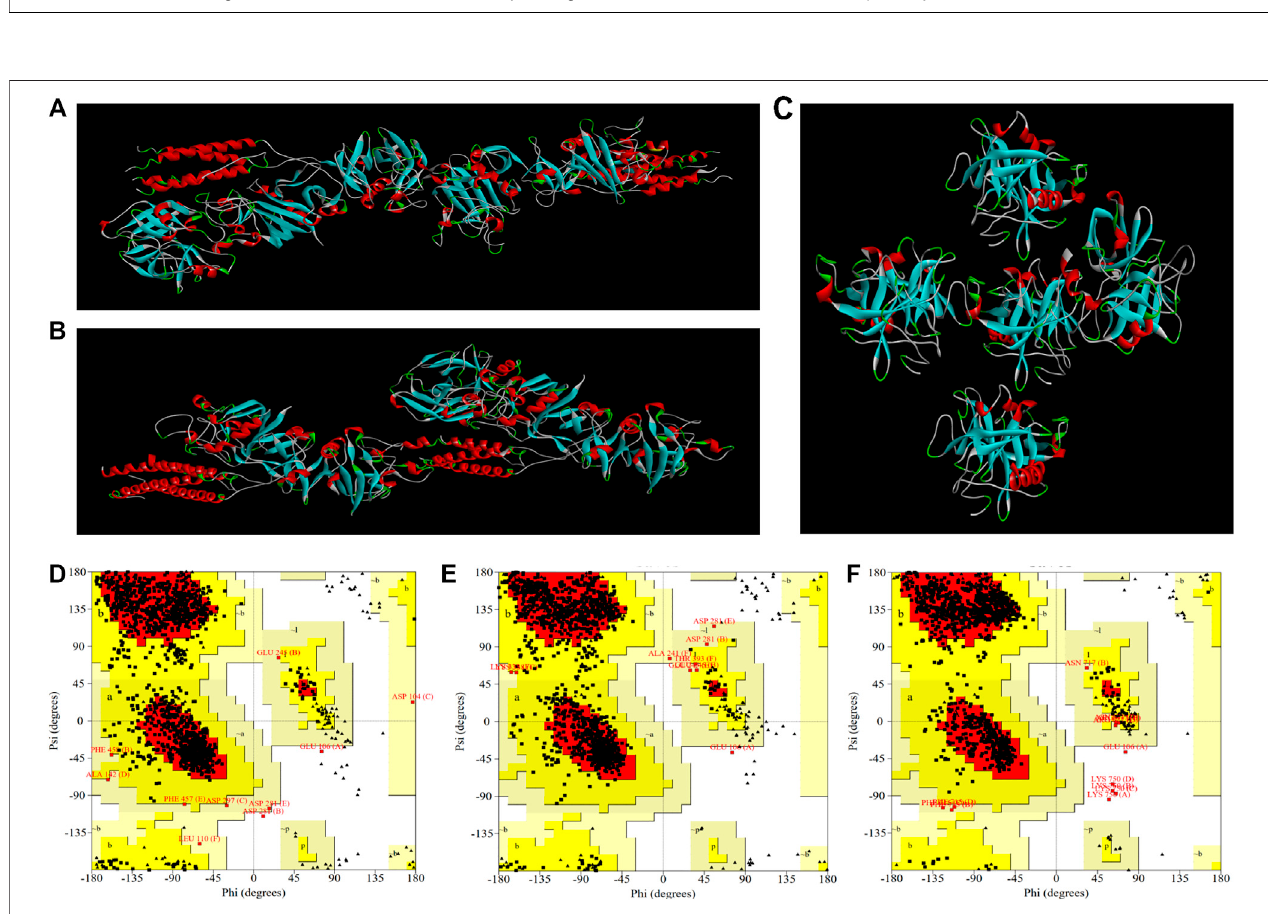
FIGURE 8 | The visualized crystal structures of EPF3 molecular docking model with fi brin (A) , fi brinogen (B), and plasminogen (C) . The Ramachandran plots of EPF3 molecular docking model with fi brin (D) , fi brinogen (E), and plasminogen (F) . Residues presented in favored, additional allowed, generously allowed, and disallowed regions were shown with red, luminous yellow, green, and white color demarcation, respectively.